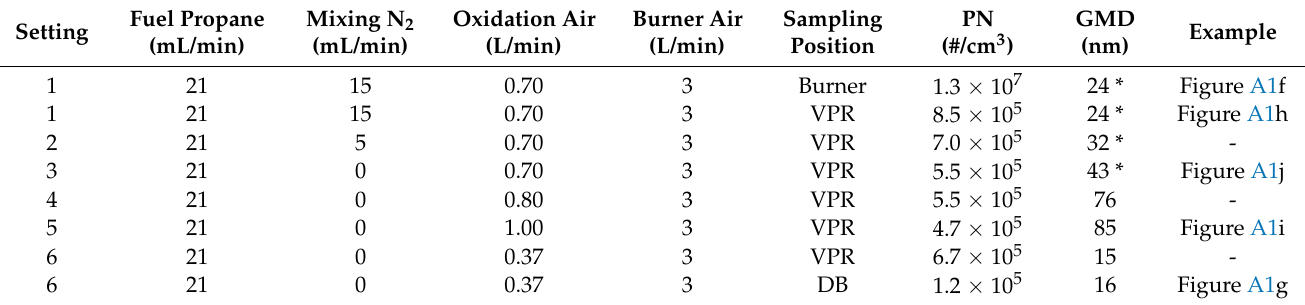
Table 1. Settings of the AVL particle generator (APG). PN and GMD refer to the inlet of the instru- ments (i.e., after the ejector